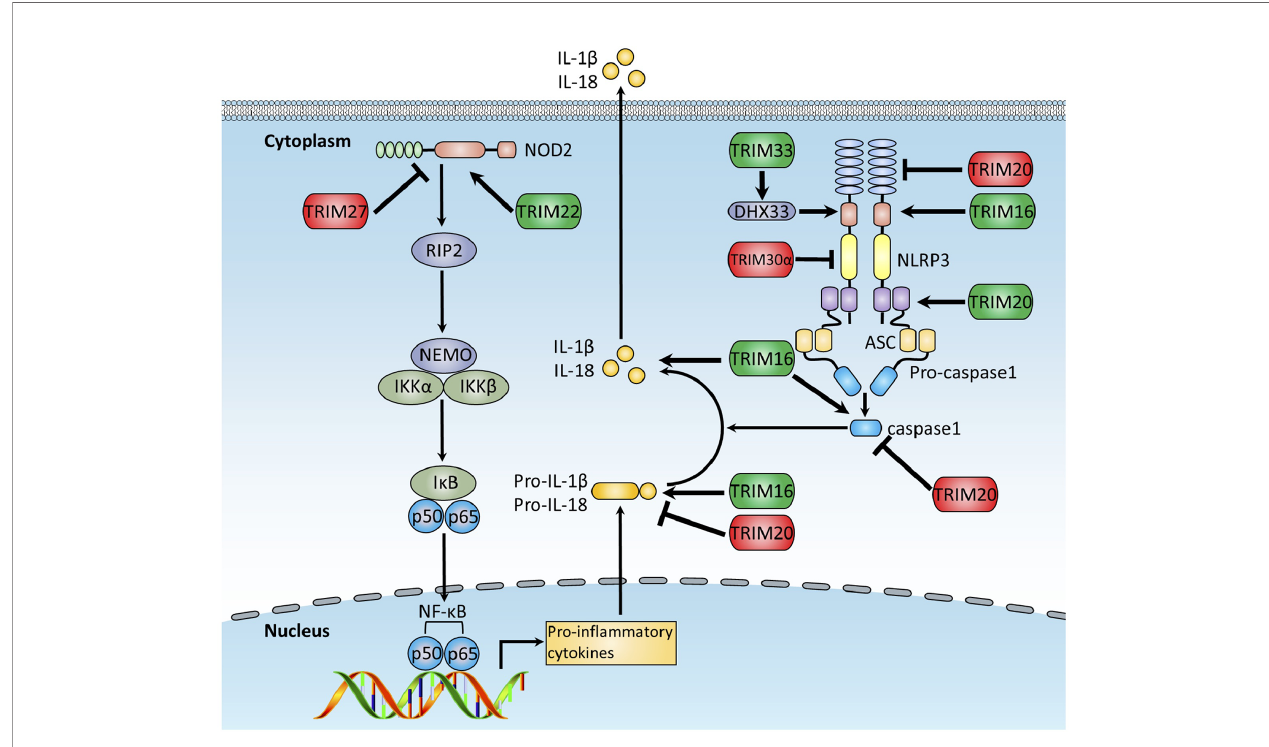
FIGURE 4 | The function of TRIMs in NLRs and in fl ammasome pathways. The NLR and in fl ammasome pathways are intracellular PRRs sensing PAMPs or DAMPs associated with cell stress. Activated in fl ammasome activates pro-caspase-1 and cleaves IL-1 b and IL-18 precursors into the functional forms, which are subsequently secreted out of the cell to induce in fl ammatory responses. This fi gure illustrates TRIM proteins regulating NLRs and in fl ammasome pathways. TRIMs promoting NLRs and in fl ammasome pathways are indicated in green, whereas these exerting the opposite functions are indicated in